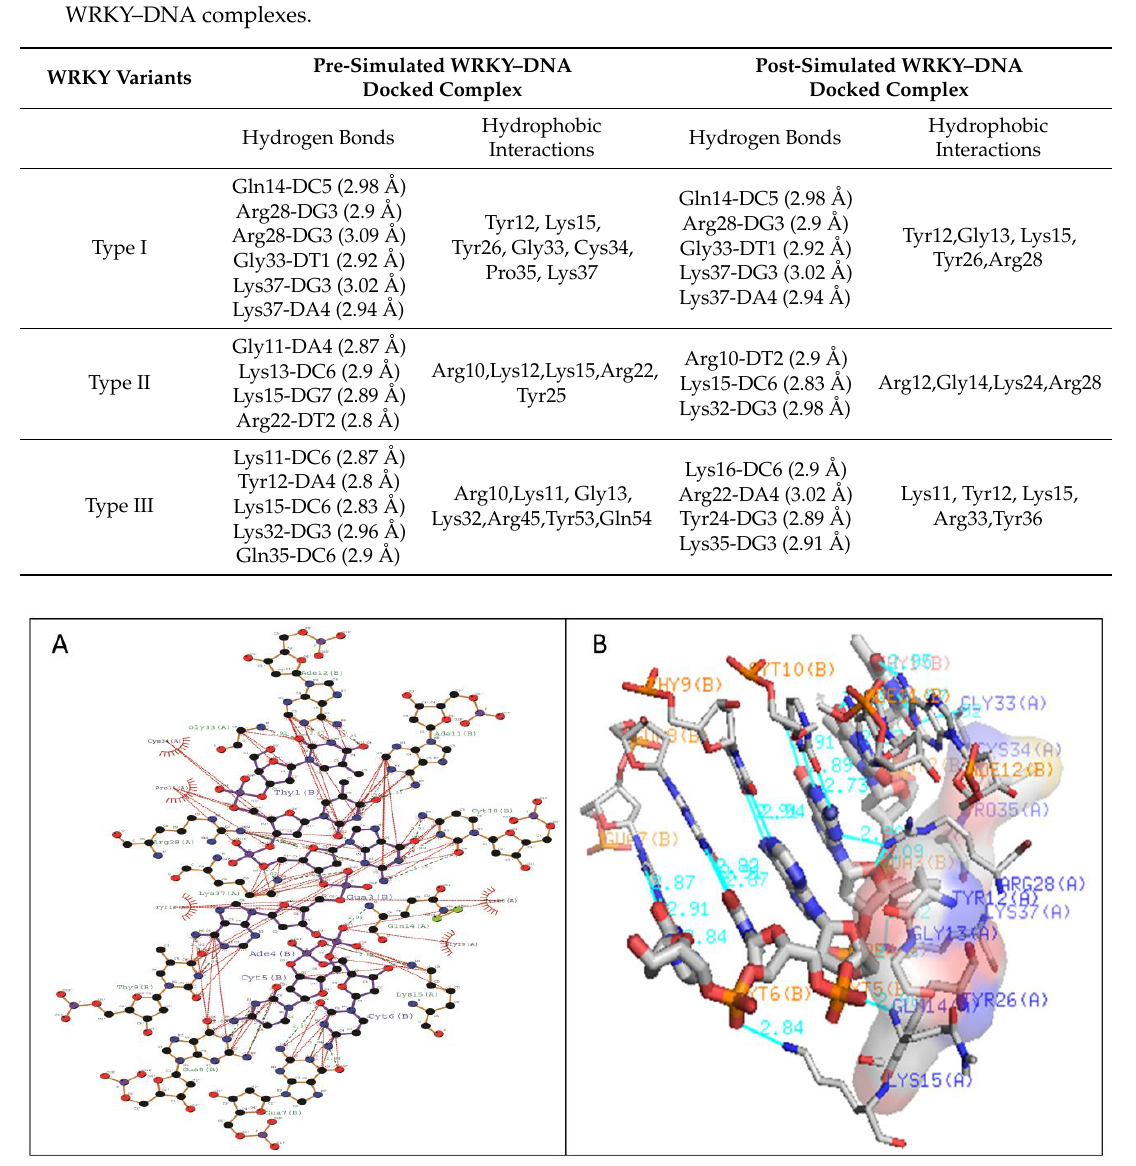
Figure 7. Illustration of ( A ) 2-dimensional and ( B ) 3-dimensional representations of the Type I WRKY protein DNA docked complex. Hydrogen bond interaction of DNA with WRKY protein amino acid residues, Gln14, Arg28, Gly33, and Lys37 (shown by the green line), whereas residues Tyr12, Gly13, Lys15, Tyr26, and Arg28 interacts through hydrophobic bonding (shown in red lines).